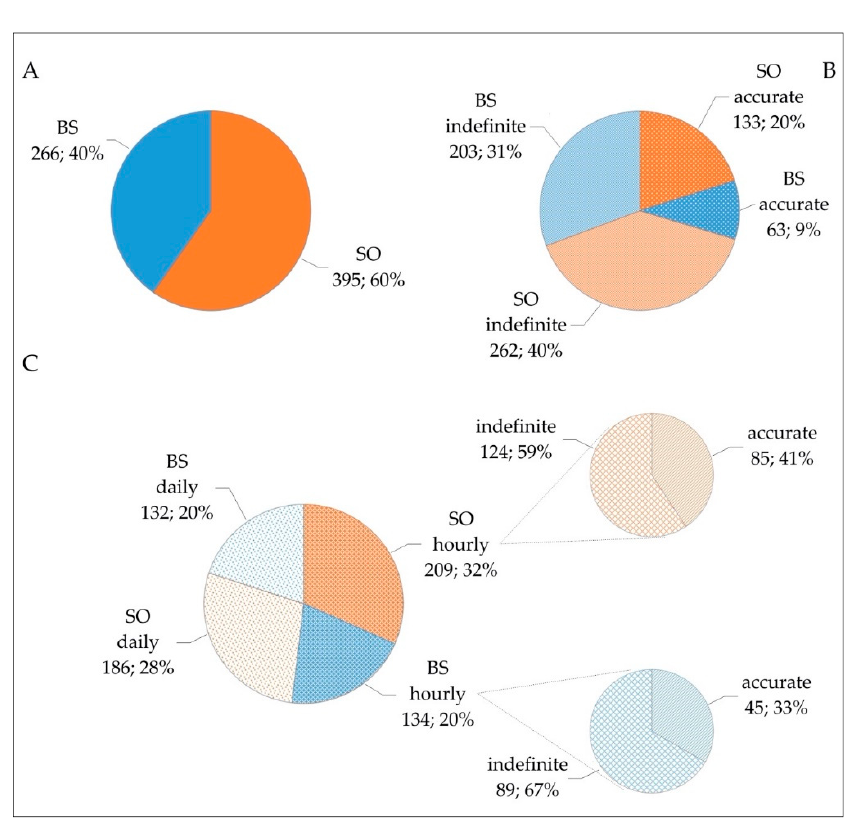
known with sufficient temporal accuracy and daily or hourly rainfall measurements. Provinces: BG, Bergamo ( purple ); BS, Brescia (blue); CO, Como ( red ); LC, Lecco ( orange ); MB, Monza Brianza; MI, Milano; SO, Sondrio ( yellow ); VA, Varese.